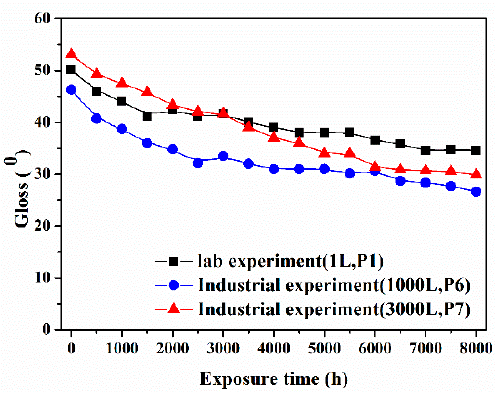
Figure 10. Change in the waterborne fluoropolymer’s gloss over time.